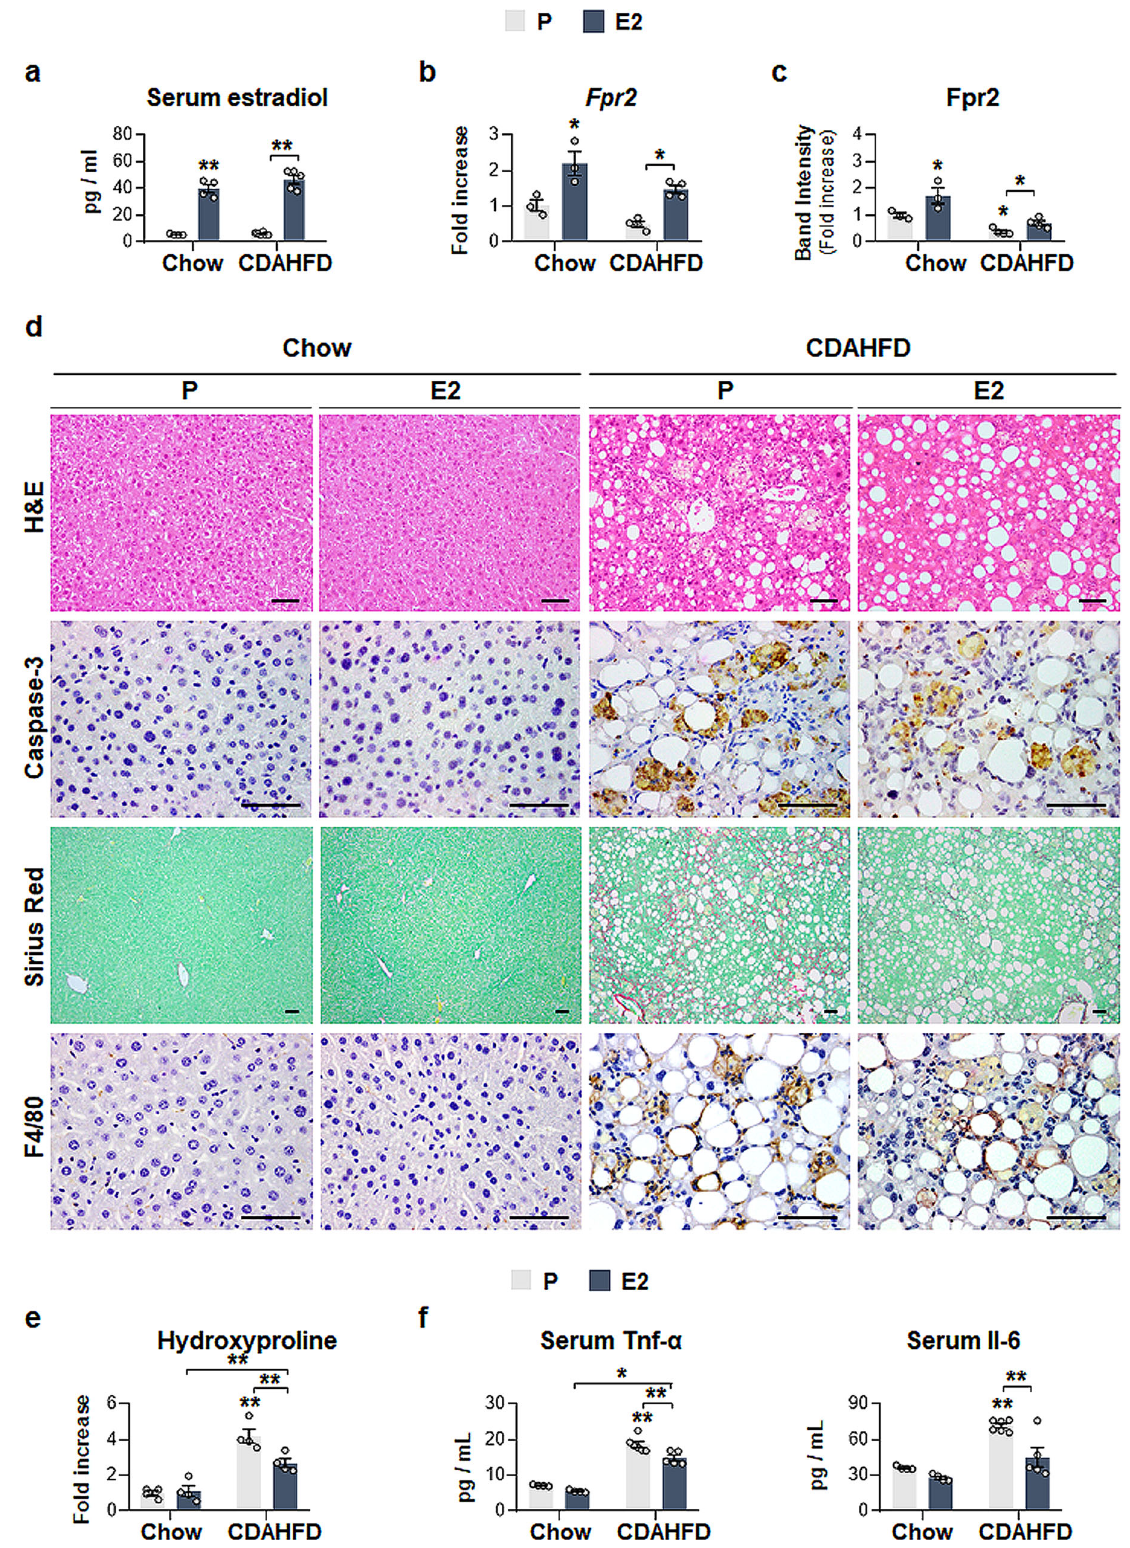
Fig. 9 Estradiol implantation elevates Fpr2 expression, and alleviate liver damage in male mice. a Amount of serum estradiol in, b qRT-PCR and c cumulative densitometric analysis for hepatic Fpr2 in placebo (P) or estradiol (E2)-supplemented male mice fed either chow or CDAHFD for 12 weeks. Band densities were normalized to the expression level of Gapdh, an internal control. Data represent the mean ± S.E.M. ( n ≥ 3/group, * p < 0.05, ** p < 0.005 vs Chow-P). d Representative images of H&E-, Caspase-3-, Sirius red-, and F4/80-stained liver sections from these mice (Scale bar: 50 μ m). e Hepatic hydroxyproline content and f serum Tnf- α and Il-6 level in these mice. Data represent the mean ± S.E.M. ( n ≥ 3/group, * p < 0.05, ** p < 0.005 vs Chow-P). Gray circles represent individual data points. See Supplementary Data for statistical